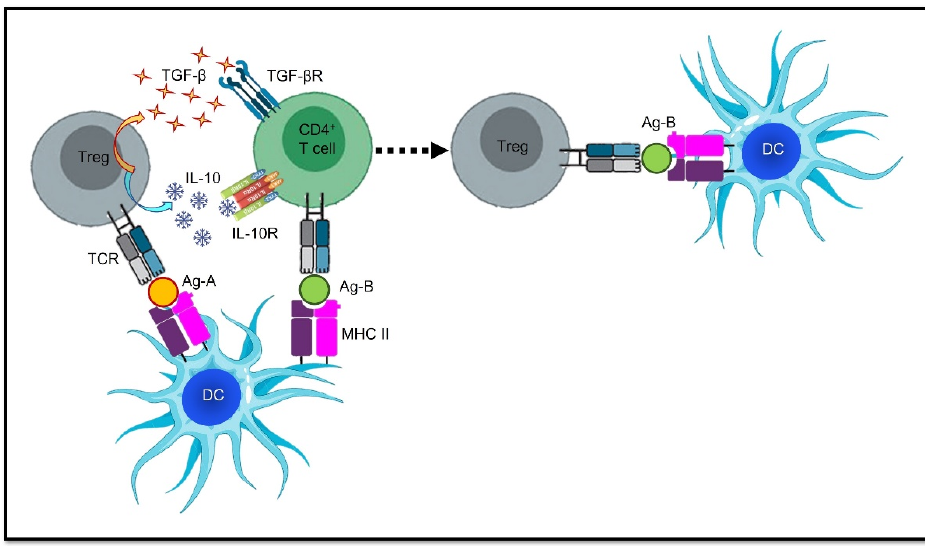
Figure 2. Schematic representation of the phenomenon of epitope spreading. A DC presents two different antigens (Ag-A and Ag-B) to a Treg and an effector CD4+ T cell, respectively. The Treg releases IL-10 and TGF- β , which educates the nearby effector CD4+ T cell so that it becomes a Treg. This results in a downregulation of the immune response towards Ag-B, even though the original tolerogenic stimulus derives from a cell specific Ag-A. Abbreviations: Ag, antigen; DC, dendritic cell; IL-10, interleukin-10; IL-10R, interleukin-10 receptor; MHC II, major histocompatibility complex II; TCR, T cell receptor; TGF- β , transforming growth factor- β ; TGF- β R, transforming growth factor- β receptor; Treg, regulatory T cell.